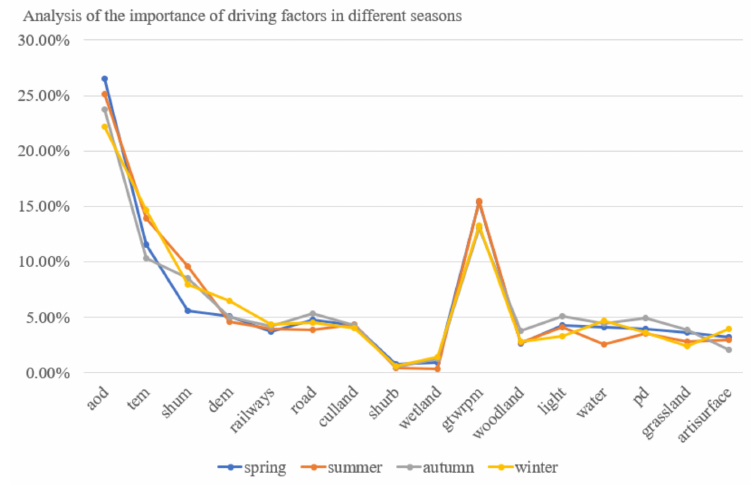
Figure 7. Analysis of the importance of driving factors in different